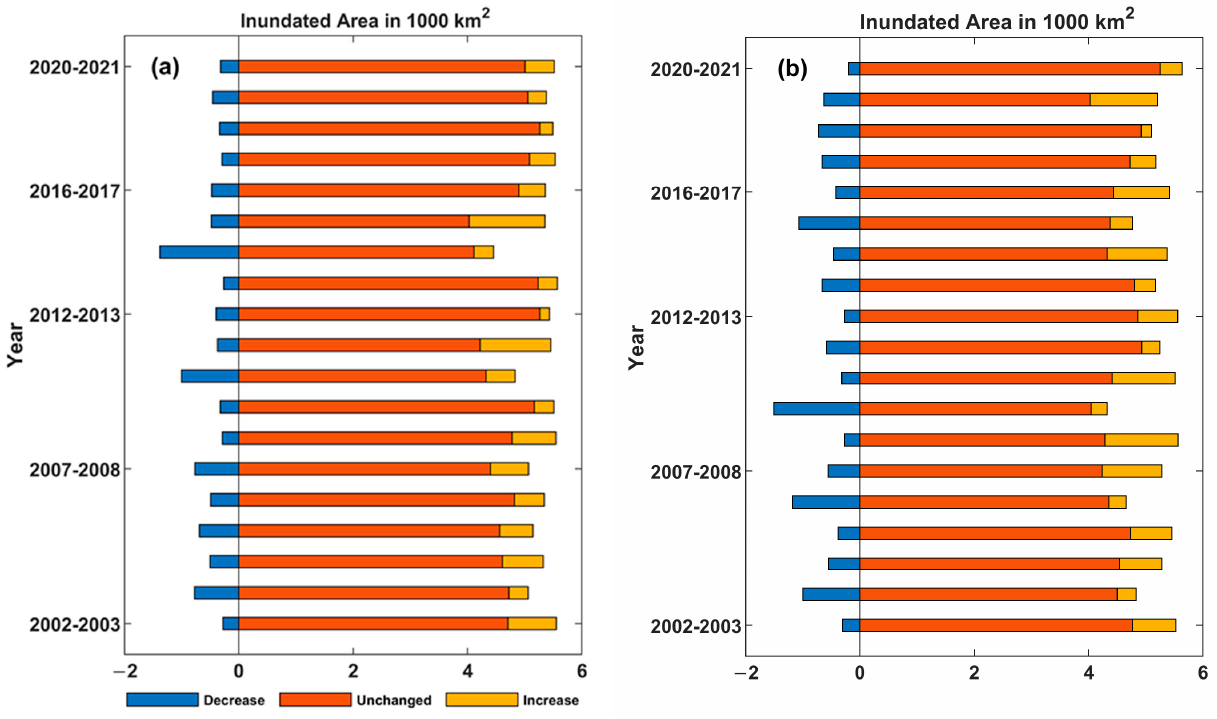
Figure 4. The annual distribution of inundation increase, decrease, and unchanged events in ( a ) wet season and ( b ) dry season. The x -axis refers to inundated area, whereas the y -axis demonstrates the comparison years. Table 1. The evolutionary trend of inundation in the study area for the wet season and dry season from 2002 to 2021.